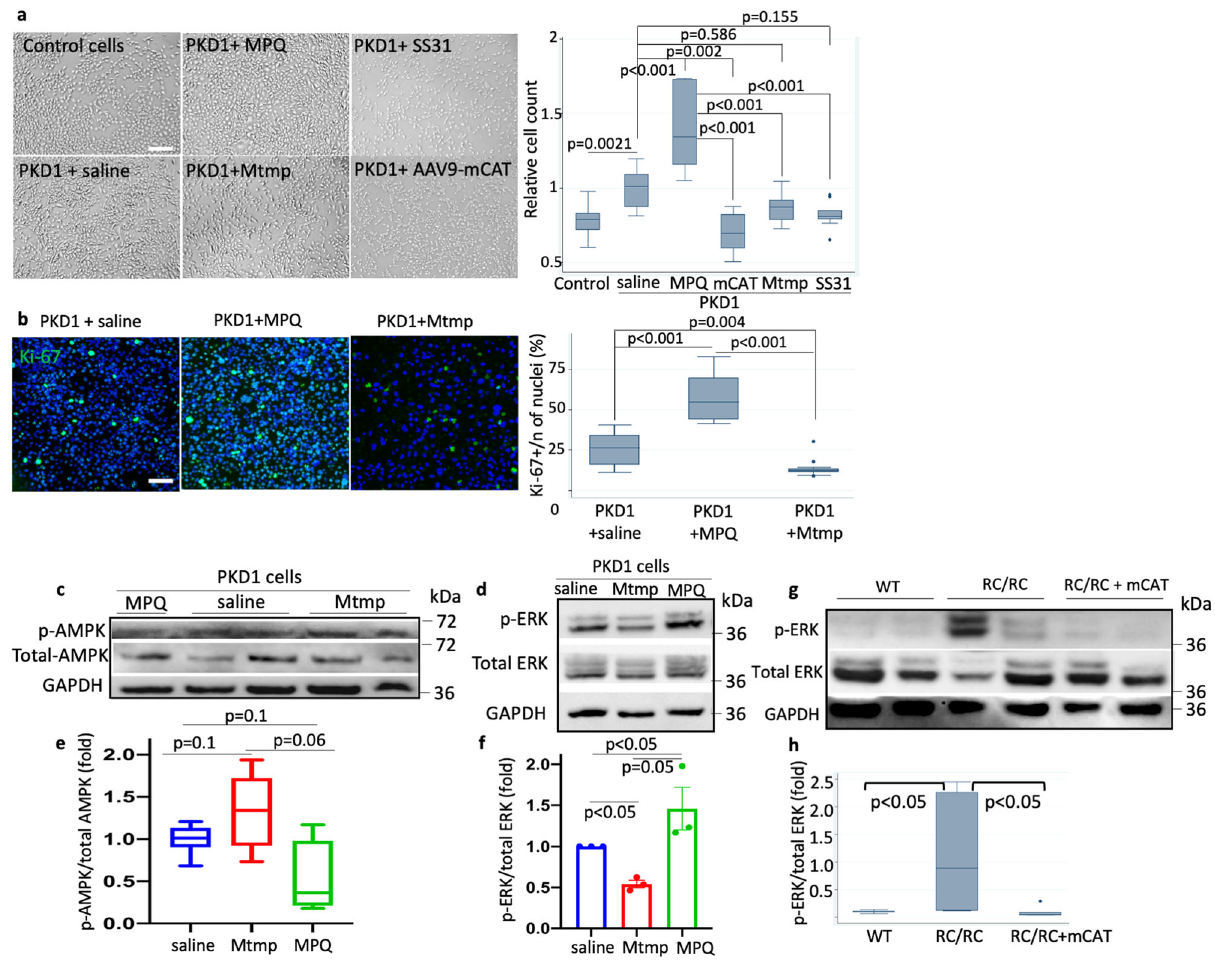
Fig. 6 Increased ERK1/2 phosphorylation and decreased AMPK phosphorylation in PKD1 mutant cells and mouse model and the effect of mitochondrial ROS. a Representative images of HK-2 control cells and WT9-7 PKD1 mutant cells treated for 24 h with saline, 25 µ M Mito-Tempo (Mtmp), 10 µ M mito-paraquat (MPQ), 10 µ M AAV9-mCAT or 10 µ M SS31 and the cell count (scale bar: 100 µ m) ( n = 3 per group). b Immunostaining of Ki-67 in PKD1 cells treated with saline, Mtmp, or MPQ and quanti fi cation of proliferation marker Ki-67; images are representatives of three independent experiments (scale bar: 100 µ m). The effect of MPQ and Mtmp on the phosphorylation of AMPK and ERK shown by immunoblotting of c phospho and total AMPK and d phospho and total ERK in PKD1 mutant cells (WT9-7) and e , f quanti fi cation of indicated groups. GAPDH was used as loading control; n = 3. g phospho and total ERK in WT, RC/RC, and RC/RC treated with AAV9-mCAT, h quanti fi cation of indicated groups. n = 3 for controls; n = 6 − 9 for treatment